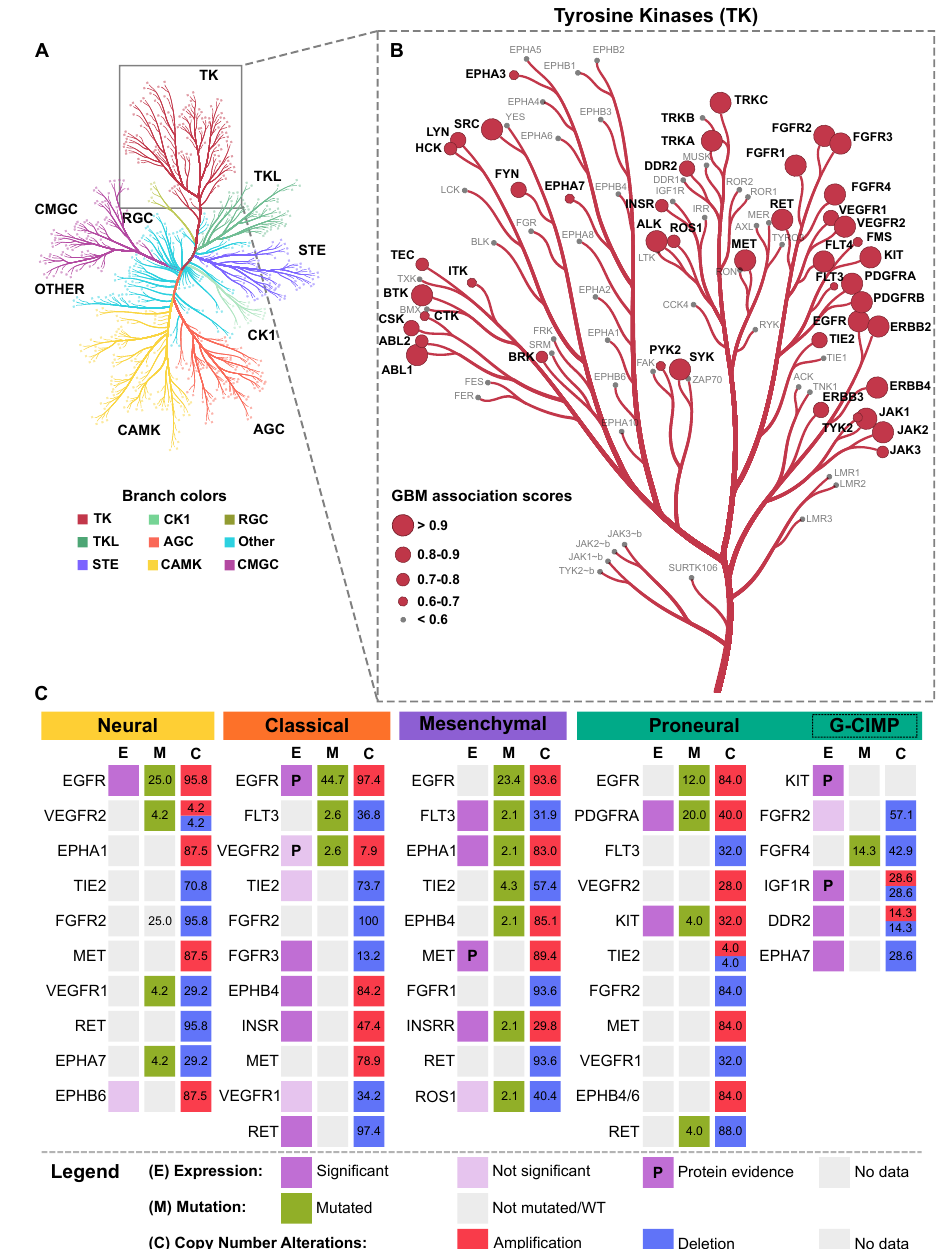
Figure 4. The human kinome and top altered receptor tyrosine kinases (RTKs) in GBM. ( A ) Kinome tree showing human protein kinases grouped on the basis of their sequence similarity. ( B ) Kinases in the tyrosine kinase (TK) group are further classified based on their unique extracellular domain arrangements (not shown). Kinome image, originally conceived by Cell Signaling Technology, Inc.